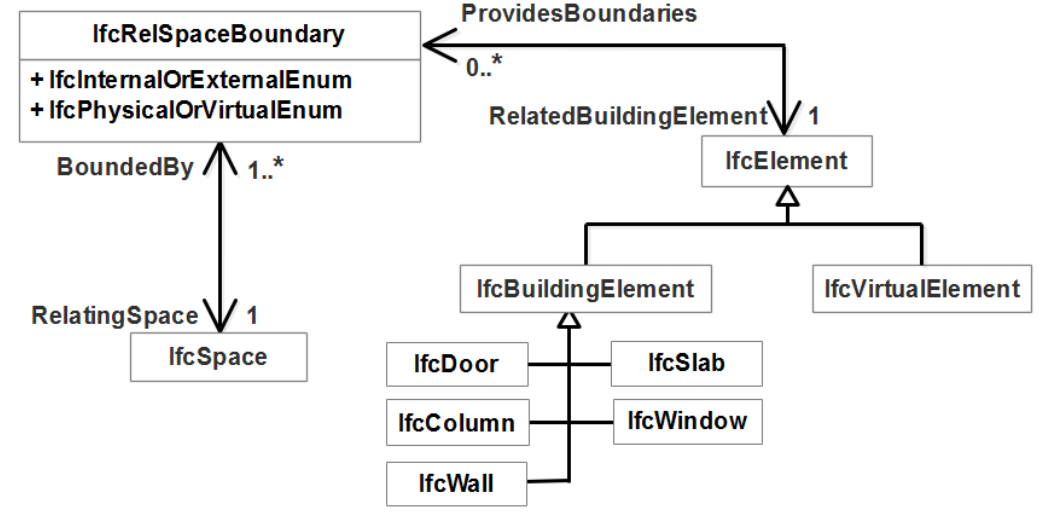
Figure 3. Required entities and relationships for querying 3D legal boundaries.